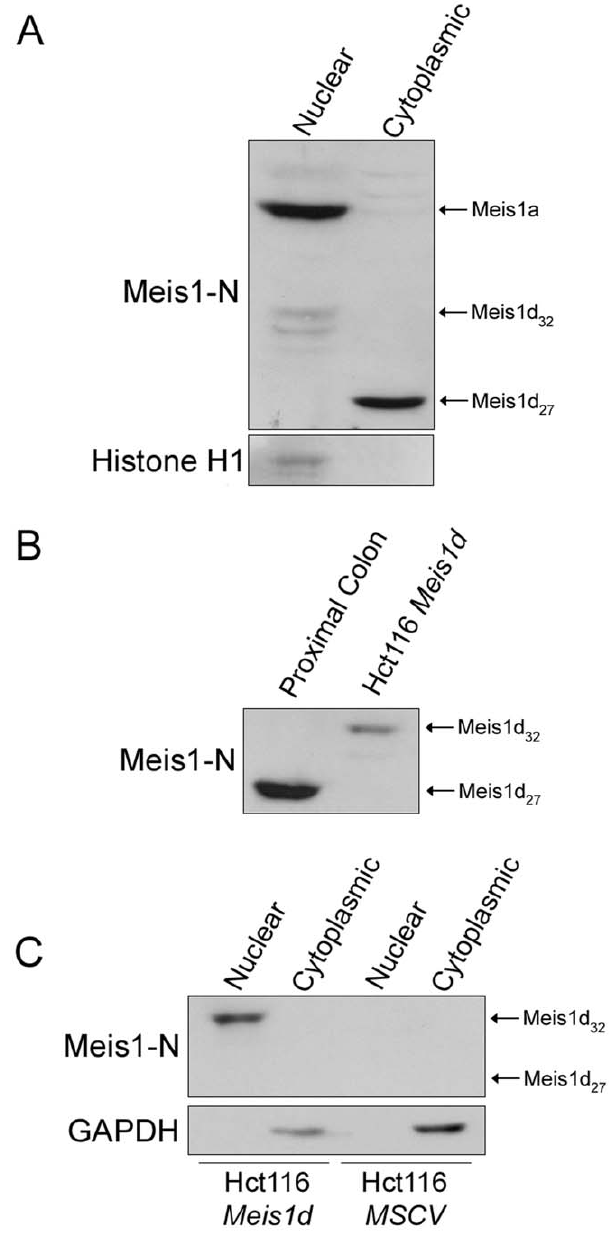
Figure 3. Posttranslational modification of Meis1d correlates with subcellular localization. A) B6 proximal colon samples were separated into nuclear and cytoplasmic fractions and probed with the Meis1-N antibody. Histone H1 was used to confirm the subcellular fractionation. B) Western blot analysis of B6 proximal colon and Hct116 cells expressing the Meis1d ORF using the Meis1-N antibody. C) Hct116 cells were retrovirally infected with the Meis1d ORF or an empty MSCV vector. Cells were taken 72 hours post-infection, fractionated, and probed with the Meis1-N antibody. The positions of Meis1a, nuclear Meis1d (Meis1d 32 ), and cytoplasmic Meis1d (Meis1d 27 ) are labeled where applicable.